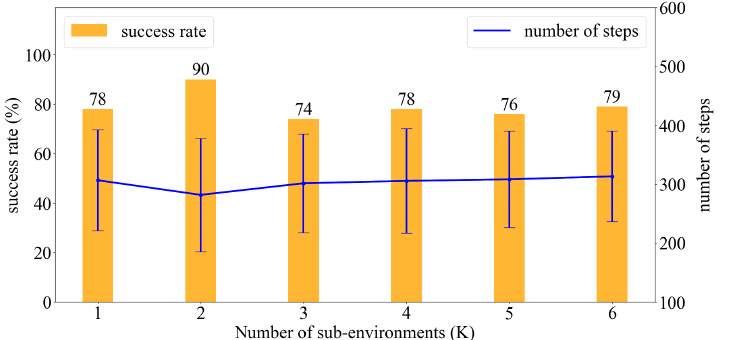
Figure 11. Calculation of success rates and average steps for a varying number of